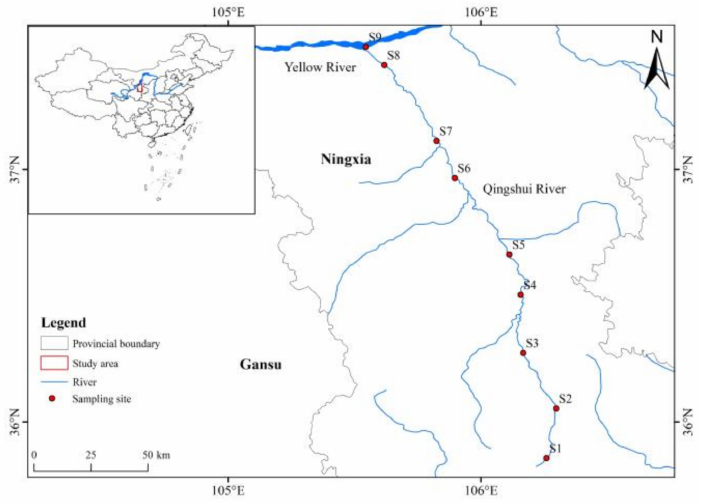
Figure 1. Sampling points of nine sediments in the main stream of Qingshui